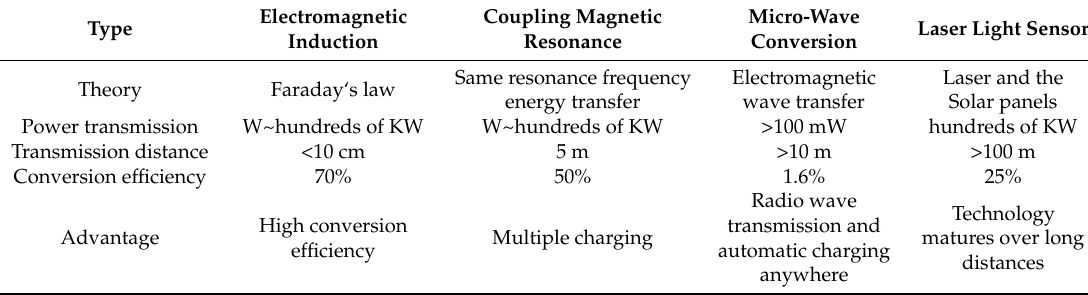
Table 2. Comparisons between wireless charging